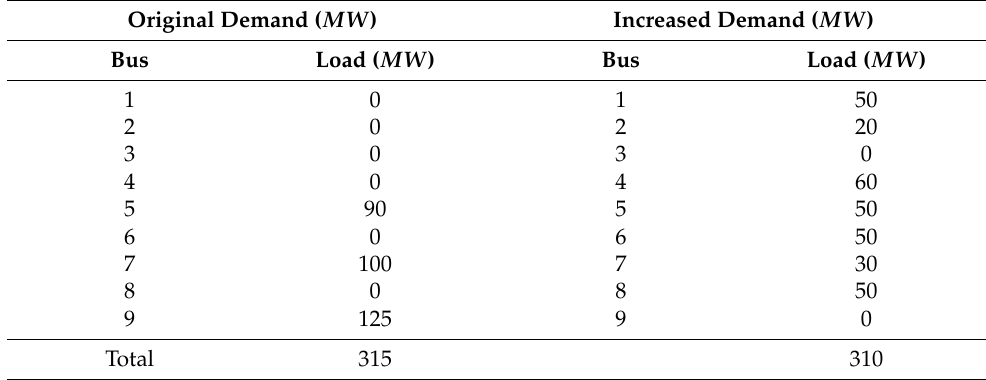
Table 5. The 9-bus system—the base year demand versus increment in energy demand.